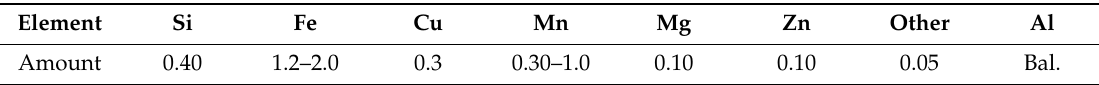
Table 1. The standard chemical composition of the EN AW 8006 alloy / wt. %. Element Si Fe Cu Mn Mg Zn Other Al Amount 0.40 1.2–2.0 0.3 0.30–1.0 0.10 0.10